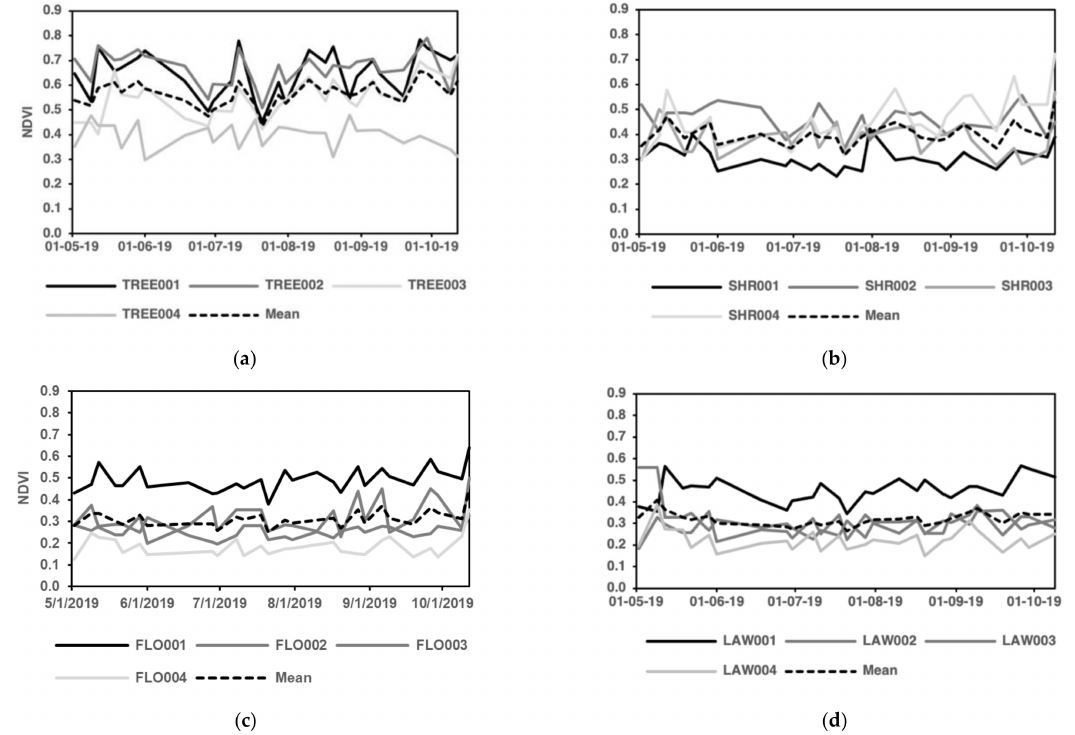
Figure 12. NDVI values for the four hydrozones selected among the four plant typologies during the 2019 irrigation season. ( a ) trees varying between 0.29 and 0.79 (average value 0.57), ( b ) for shrubs varying between 0.23 and 0.72 (average value 0.40), ( c ) for the flower collections varying between 0.13 and 0.64 (average value 0.31), and ( d ) for lawn varying between 0.15 and 0.65 (average value